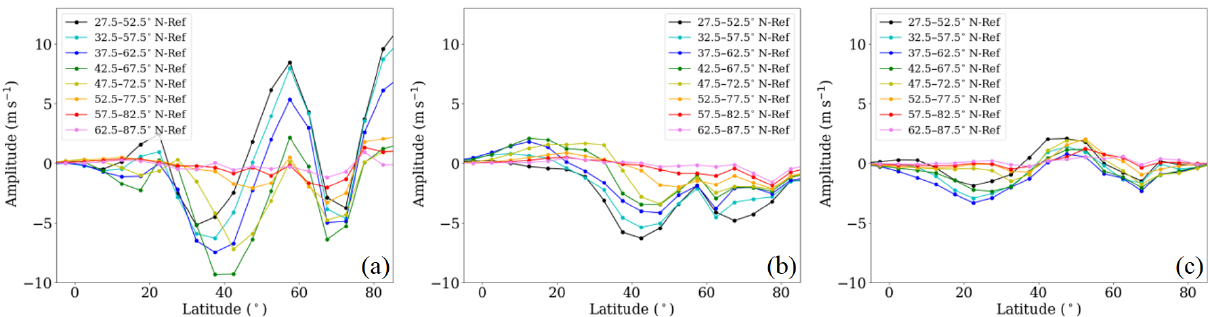
Figure 7. Zonal mean SPW 1 (a) , SPW 2 (b) and SPW 3 (c) amplitudes as the difference between the H1–H8 simulations and the Ref simulation at 35km for the last 30d of the simulations extracted from the zonal wind.